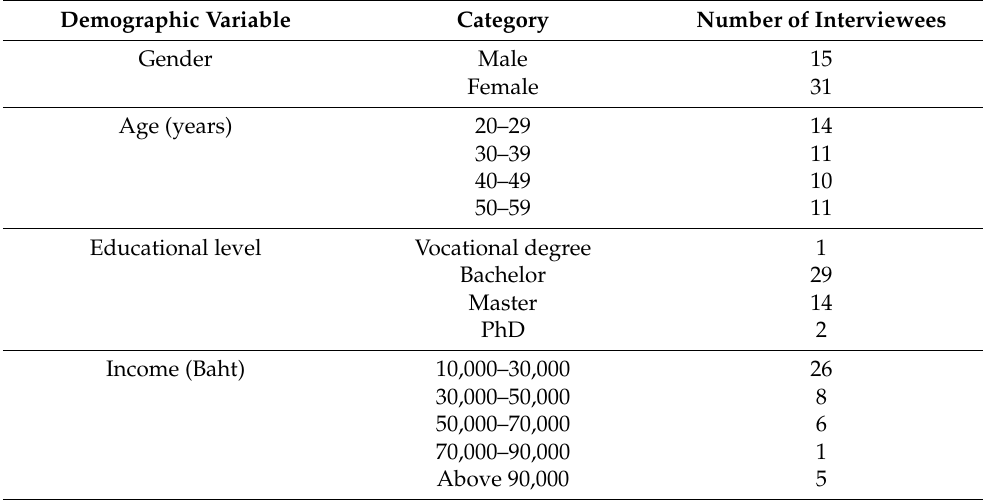
Table 1. Demographic profiles of interviewees ( n =